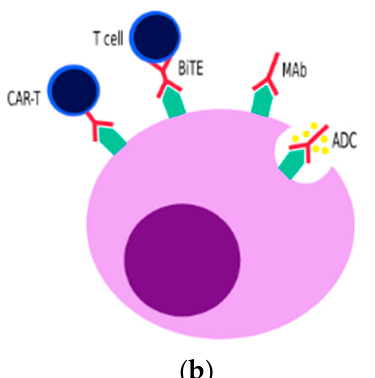
Figure 1. Overview of Immunotherapy in Multiple Myeloma. ( a ) Overview of di ff erent types of immunotherapy in MM. ( b ) Overview of how di ff erent types of immunotherapy may target the same antigen on a myeloma cell.